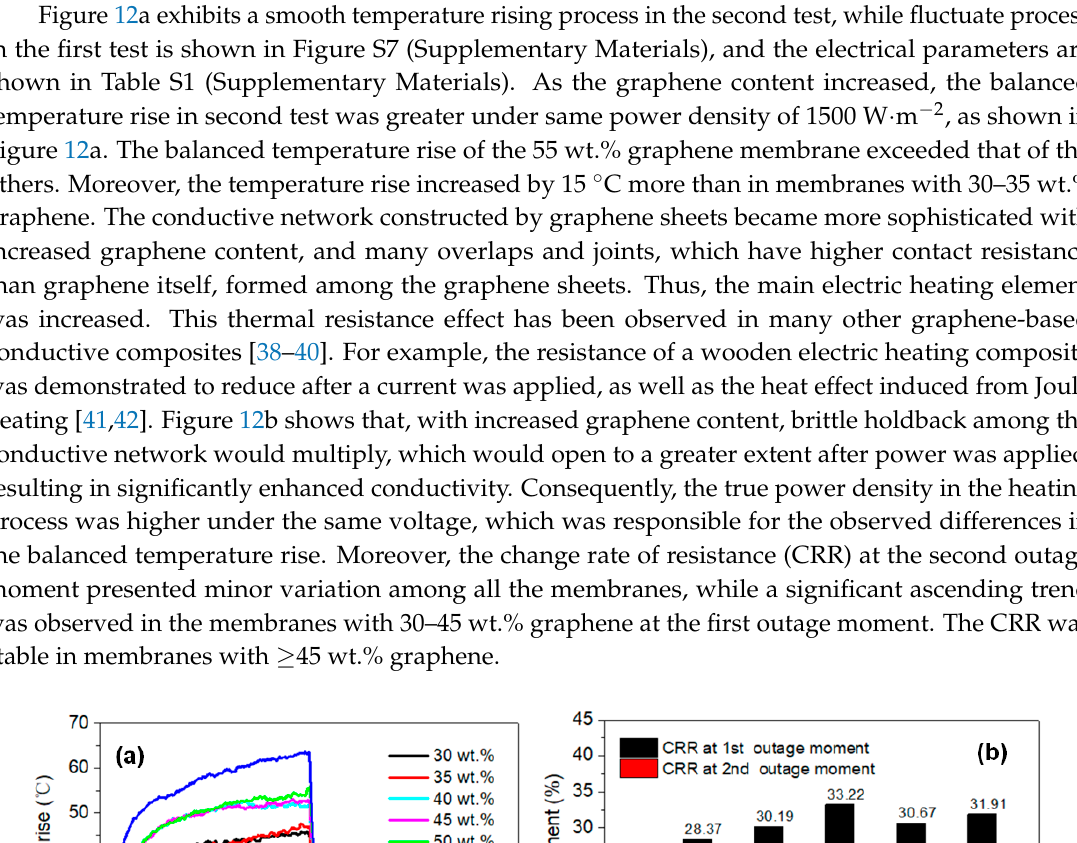
Figure 13. ( a ) Temperature rise of membranes with various grammages; ( b ) Exponential fitting of the 4 and 16 g·m − 2 membranes. As shown in Figure 14, the temperature of the membrane rose quickly for the first 300 s, and then tended to stabilize. As the power density increased, the temperature rise of the membrane increased linearly, which can be illustrated from the fitting analysis results ( y = − 2.76 + 0.03716 x ; R 2 = 0.98863; in which y is the temperature rise, and x is power density). Thus, a temperature rise of